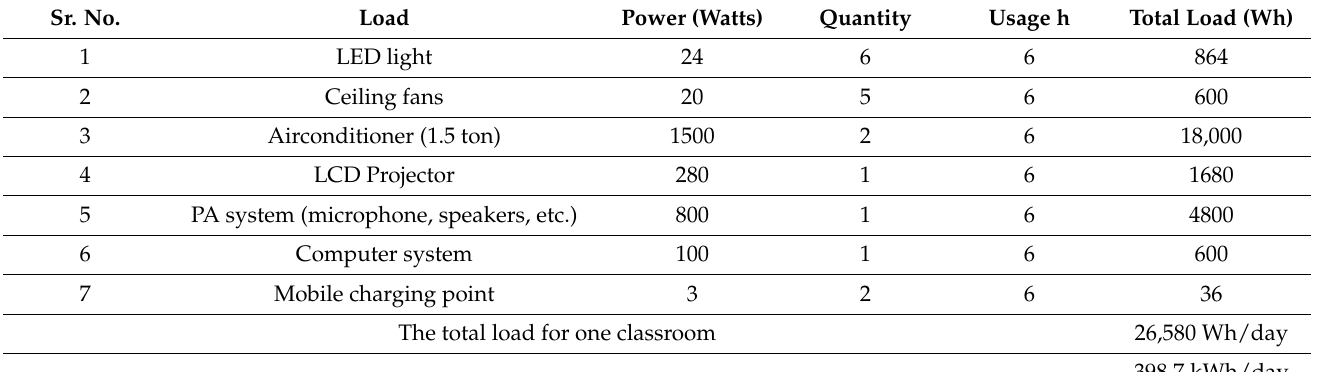
Table 1. Load estimation of 15 classrooms at the campus of the selected site.